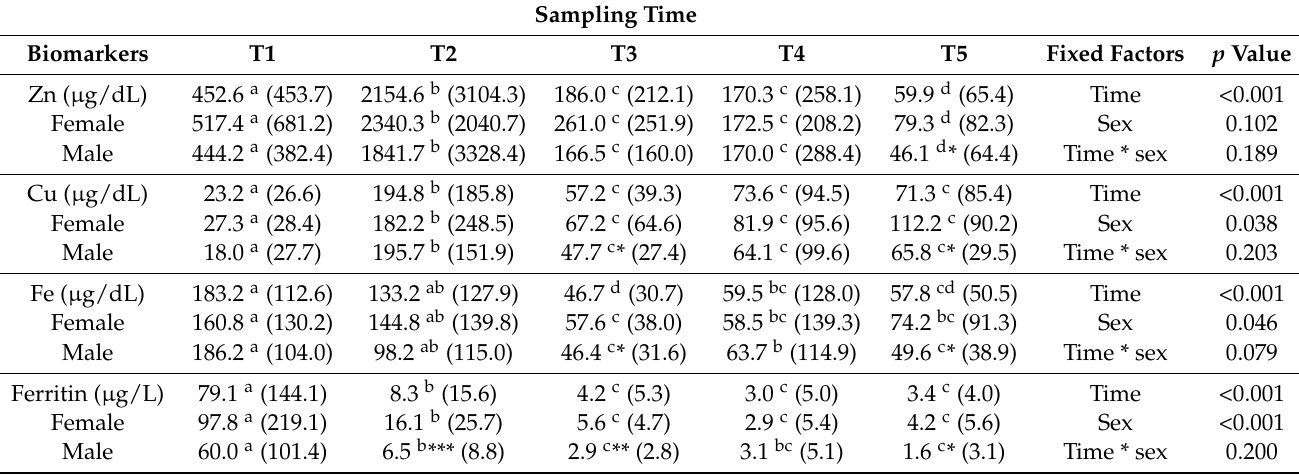
Table 1. Results obtained of salivary zinc, copper, iron and ferritin in 45 Large White pigs (21 females, 24 males) at suckling phase (T1); beginning (T2) and end (T3) of nursery phase; beginning (T4) and end (T5) of growing phase. Median (interquartile range) are